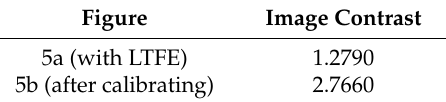
Table 3. Image contrast of Figure 5. Figure